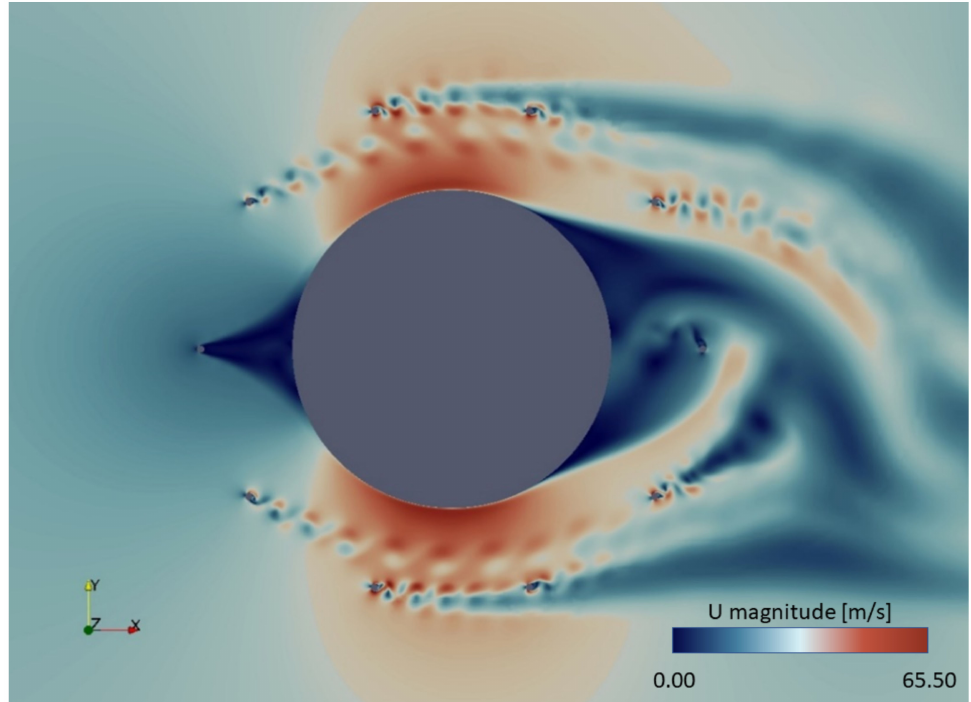
Figure 14. The velocity field in the vicinity of the vertical frame elements and lantern housing (Velocity, U, in